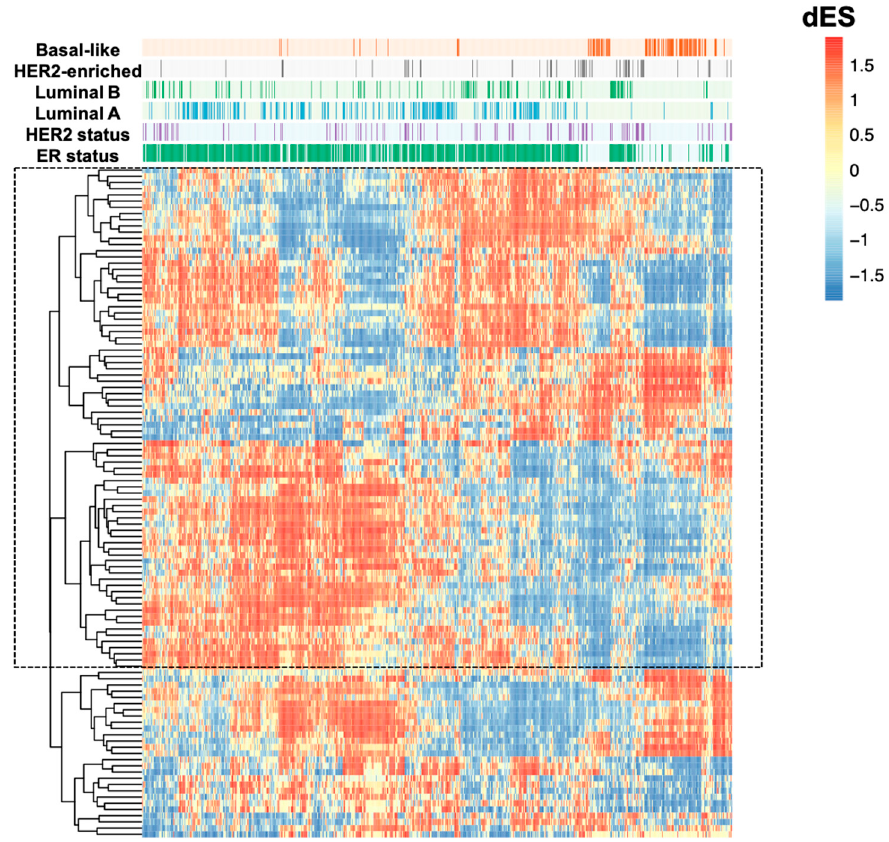
Figure 1. Heatmap representation of the 84 lncRNA co-expression networks activity in breast cancer molecular subtypes. According to this metric, positive dES (in red) are activated; and negative dES (in blue) are inactivated. In the highlighted rectangle are the more contrasting between luminal A and basal-like subtypes. The samples are organized in the heatmap columns and categorized according to the annotation bar at the top of the graph. The TCGA BRCA cohort samples were classified according to their molecular classification and estrogen receptor and HER2 status. LncRNAs in their co-expression networks ( n = 84) are clustered in the rows and can be found in Supplementary Table S2.